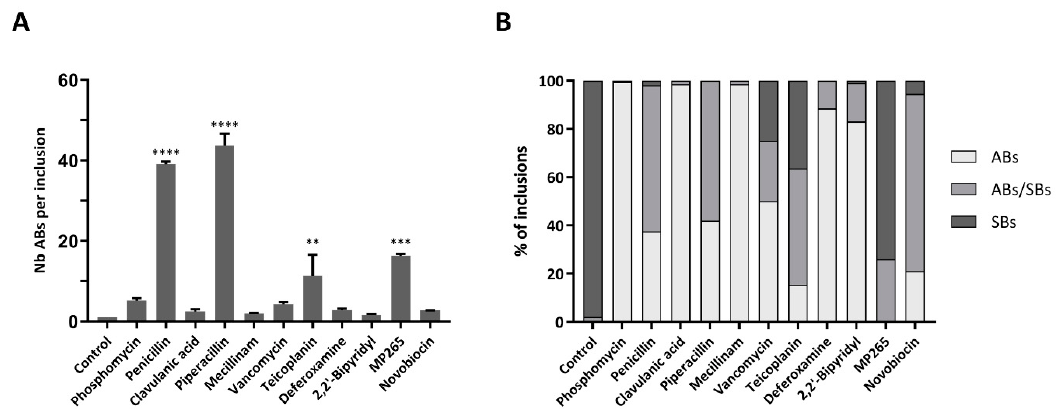
Figure 3. Effects of the stress stimuli on the number of ABs per infected cells and on the inclusion composition at 24 hpi. W. chondrophila -infected Vero cells were treated at 2 hpi with the indicated drugs at concentrations indicated in Table 1 and then processed as in Figure 2. ( A ) Mean number of ABs per inclusion according to the stress stimuli treatment. The results show the mean ± SD of 50 infected cells from one representative experiment counted in duplicate. Number of ABs were counted on z-stack images of confocal microscopy. Significant differences between control and the other treatments determined with the one-way analysis of variance (ANOVA) are indicated by an asterisk (* p < 0.05, ** p < 0.01, *** p < 0.001, **** p < 0.0001). ( B ) Percentage of inclusions containing ABs only, ABs and SBs, or SBs only. From one representative experiment, 200 inclusions were counted.